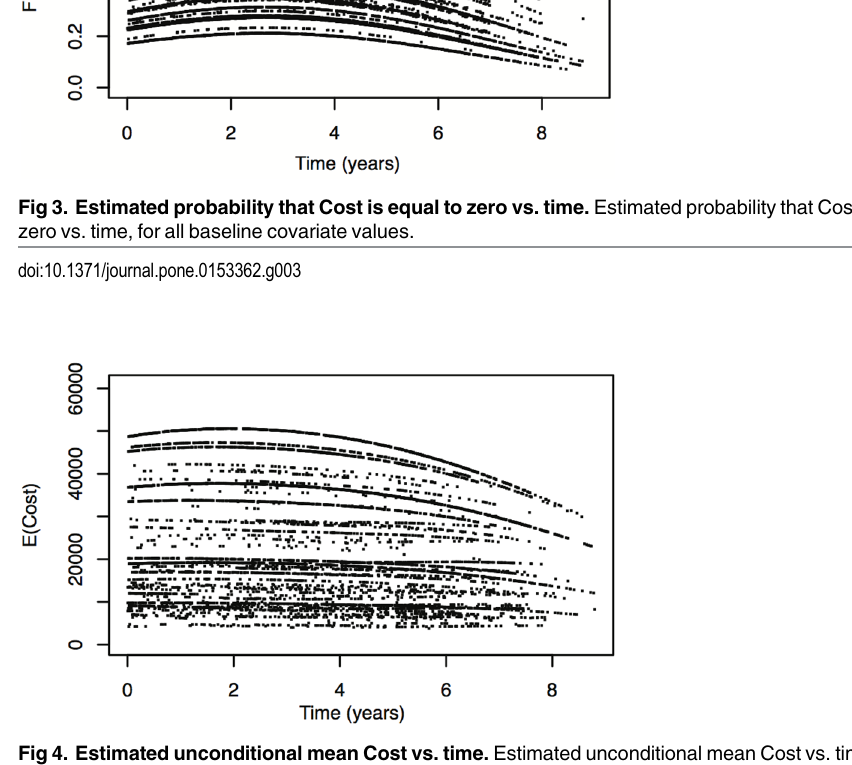
Fig 4. Estimated unconditional mean Cost vs. time. Estimated unconditional mean Cost vs. time, for all baseline covariate